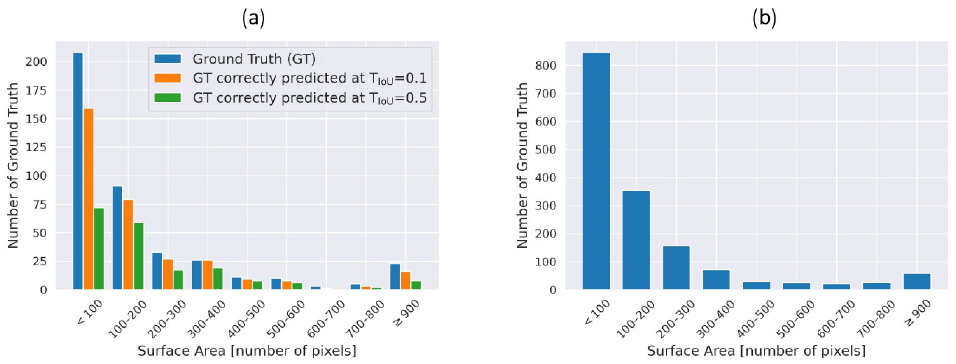
Figure 7. Ground truth surface area histogram on ( a ) test set and ( b ) train